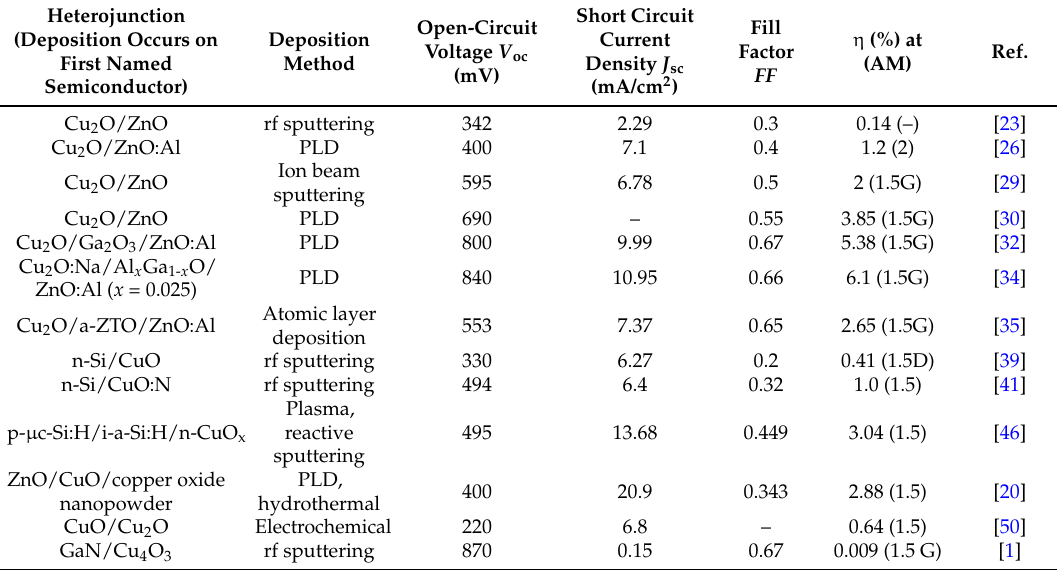
Table 1. Photovoltaic parameters of Cu 2 O and CuO heterojunction solar